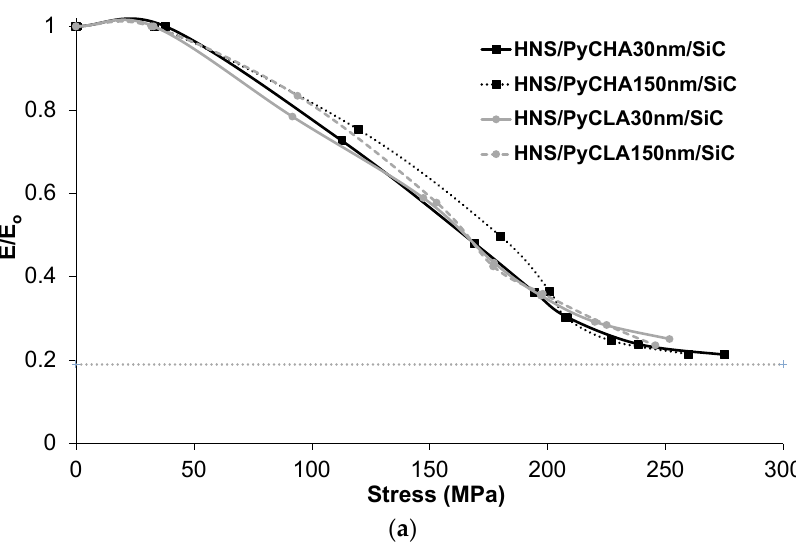
Figure 9. Typical tensile stress–strain behaviors with unloading–reloading sequences with evolution of cumulated AE signal for ( a ) HNS/PyC HA30nm /SiC, ( b ) HNS/PyC HA150nm /SiC, ( c ) HNS/PyC LA30nm /SiC and ( d ) HNS/PyC LA150nm /SiC.